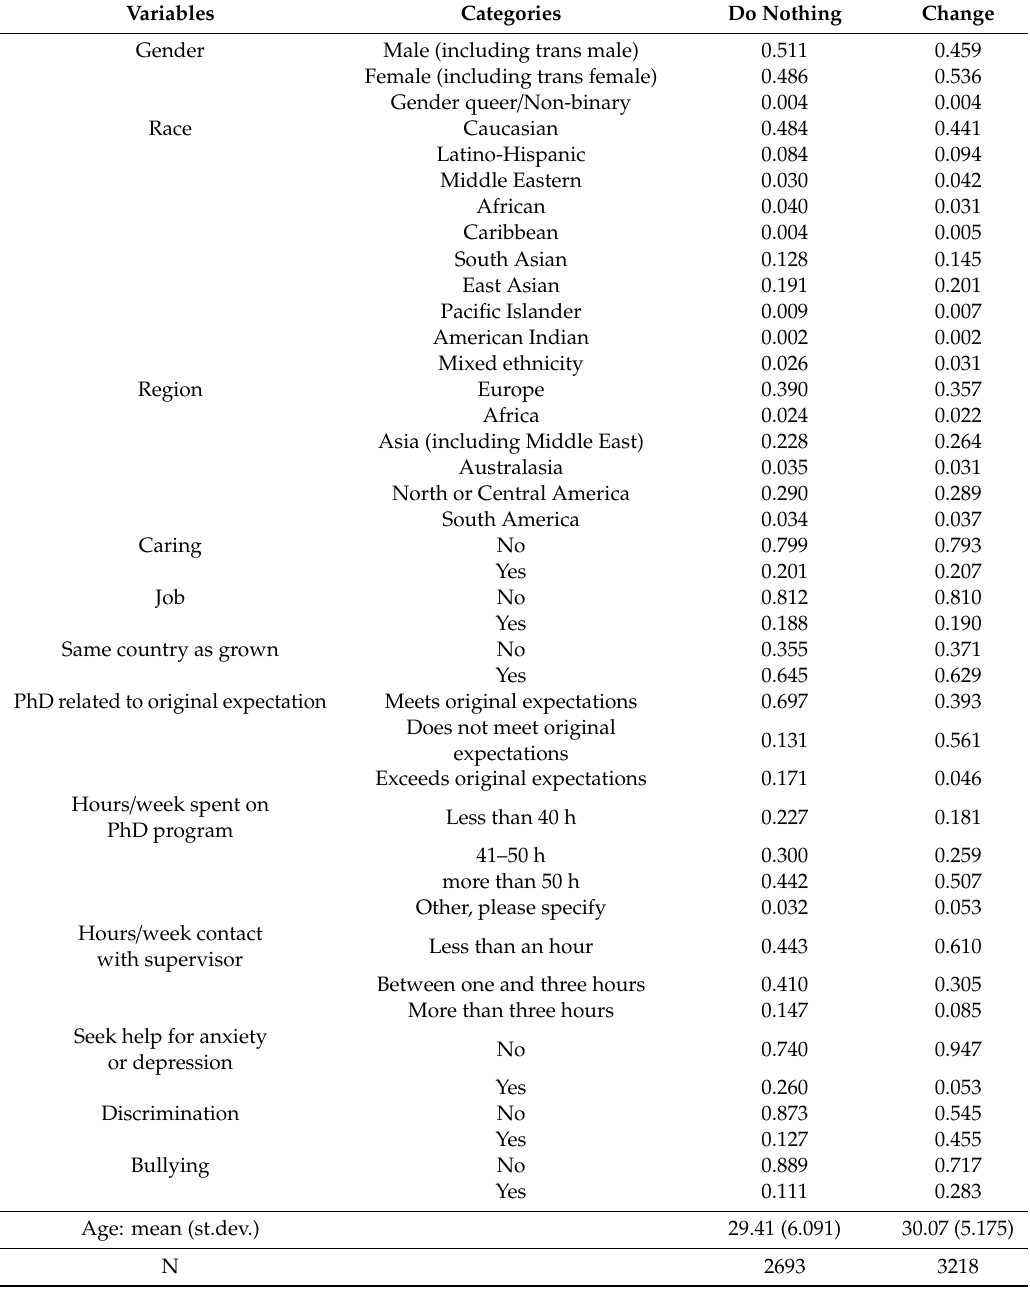
Table A1. Descriptive statistics of the explanatory